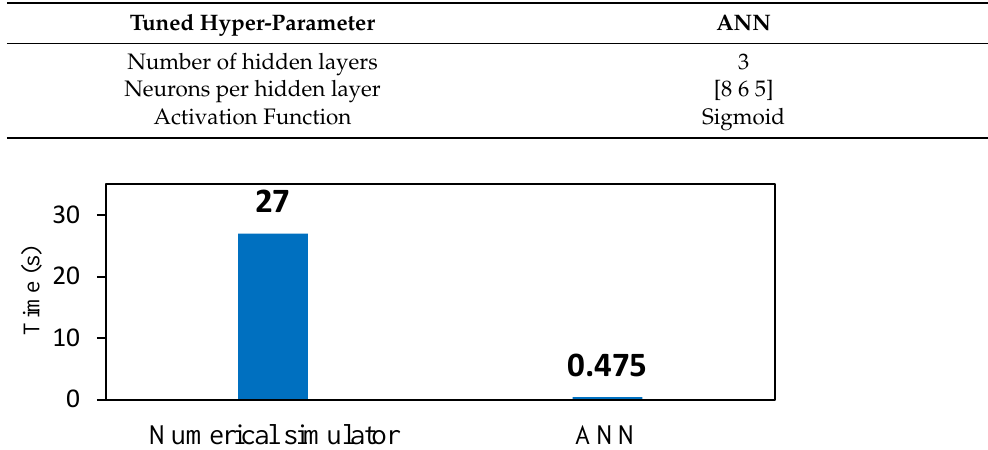
Figure 7. Computation time of numerical simulator and ANN model.